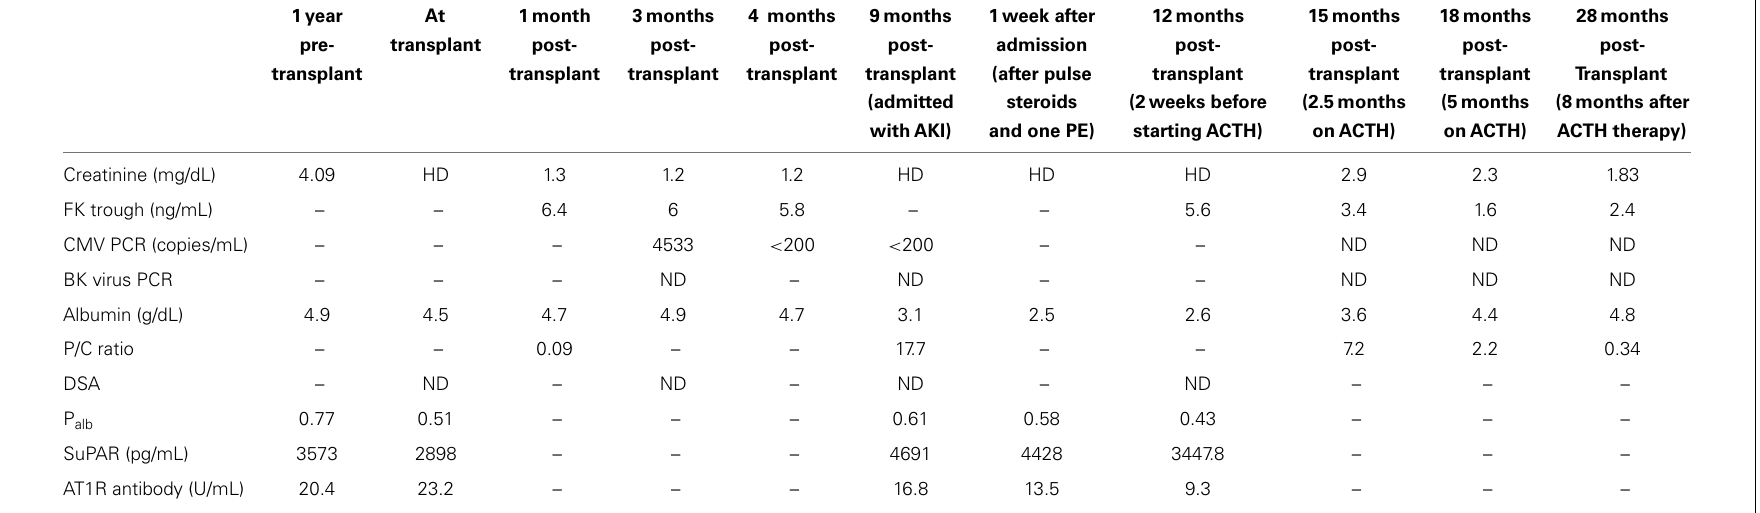
Table 1 |Time course of clinical events, laboratory results and biomarkers